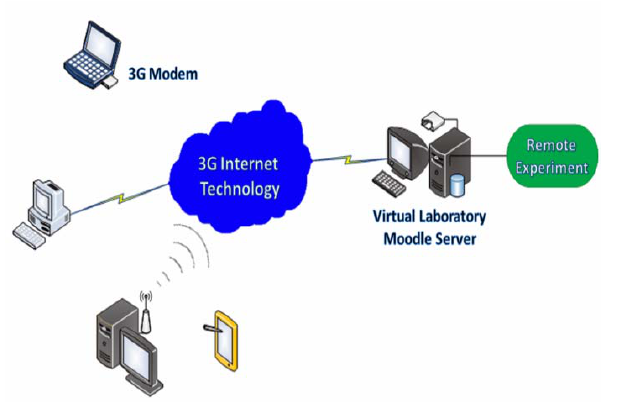
Figure 15. Ventilator connected to the PWM modulator remote experi- ment via